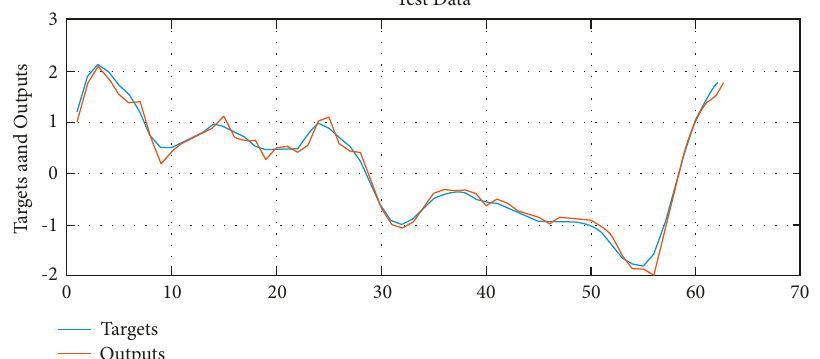
Figure 8: Final test data set for the prediction.